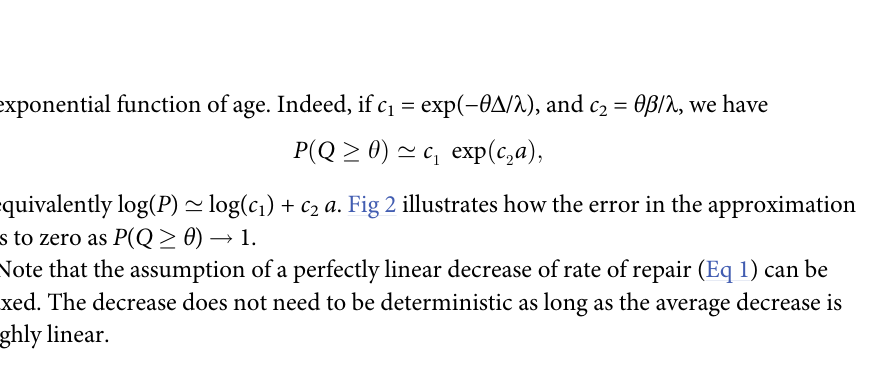
Fig 2. Probability of Q ( a ) � θ as a function of age for a model with λ = 500, Δ = 50, β = 0.485/365, all in units of per day, and θ = 80. True values from Eq 2 and approximation from Eq 6.